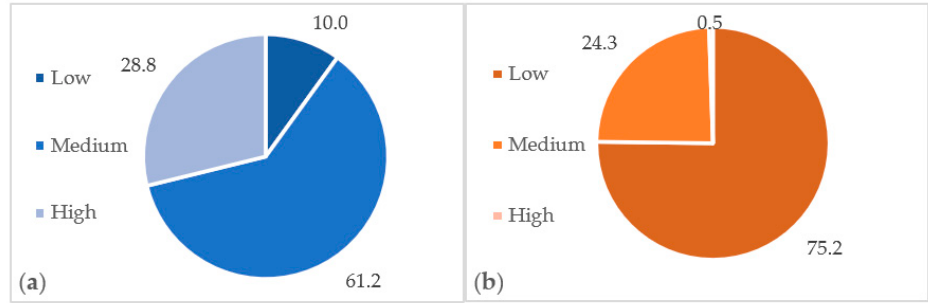
Figure 4. Hydraulic simulation results for 371 service connections, ( a ) pressure distribution, ( b ) ve- locity distribution.